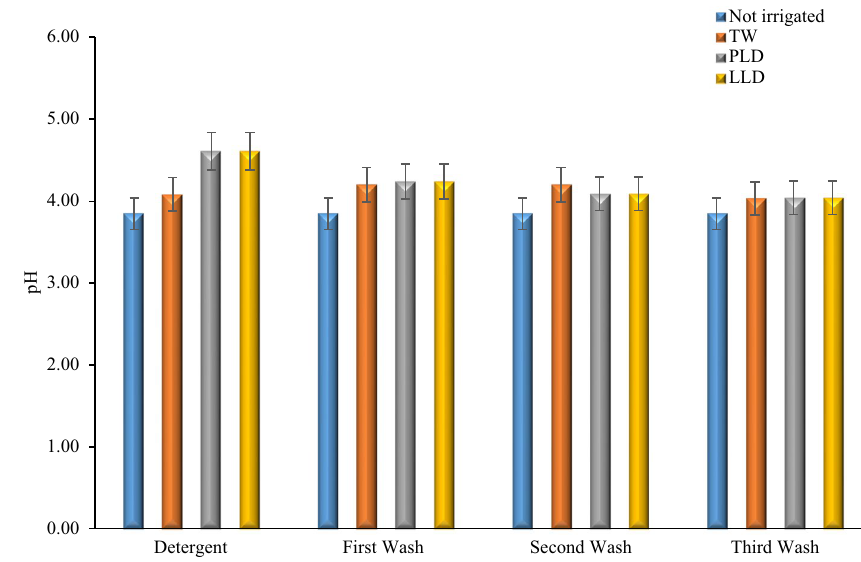
Fig. 1 pH of soil leachate after irrigated with tap water (TW), powder laundry detergent (PLD) and liquid laundry detergent (LLD) greywater; not irrigated (control)